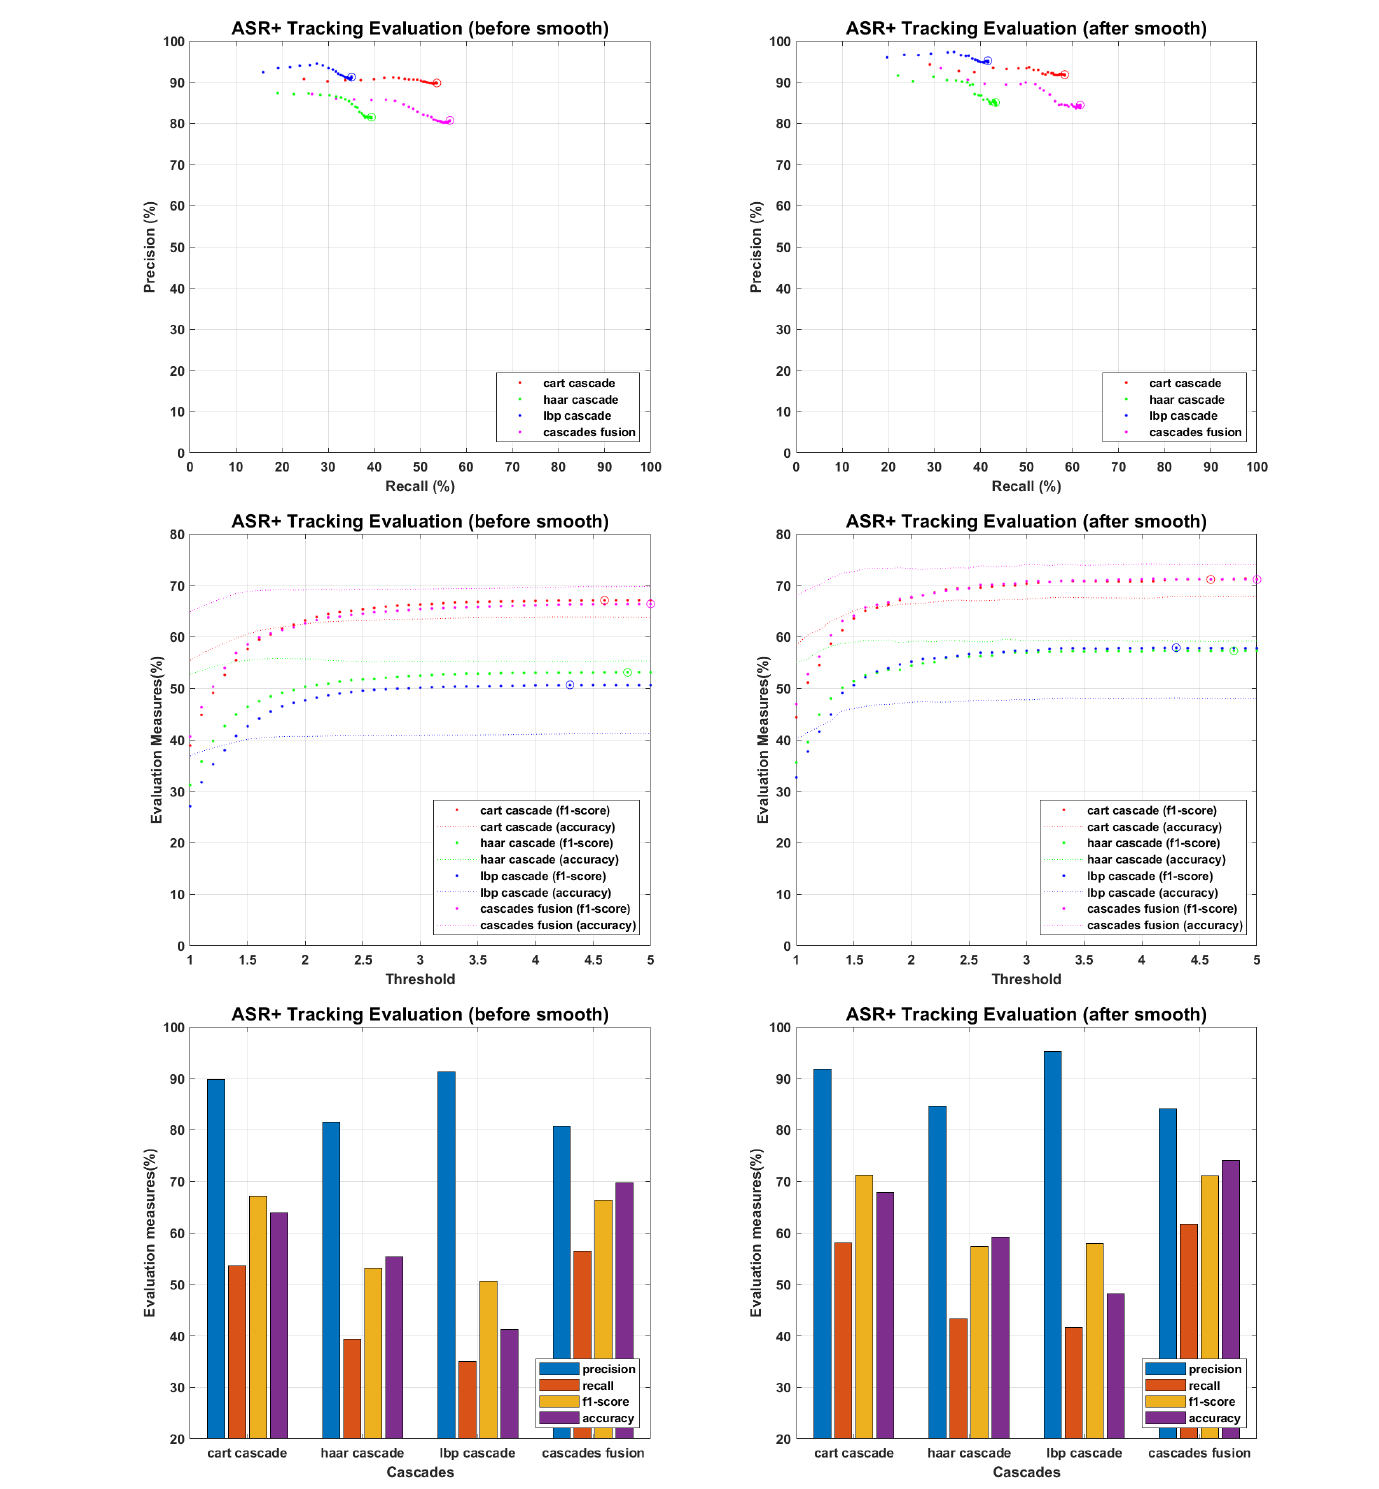
Figure 19. Tracking Evaluation for